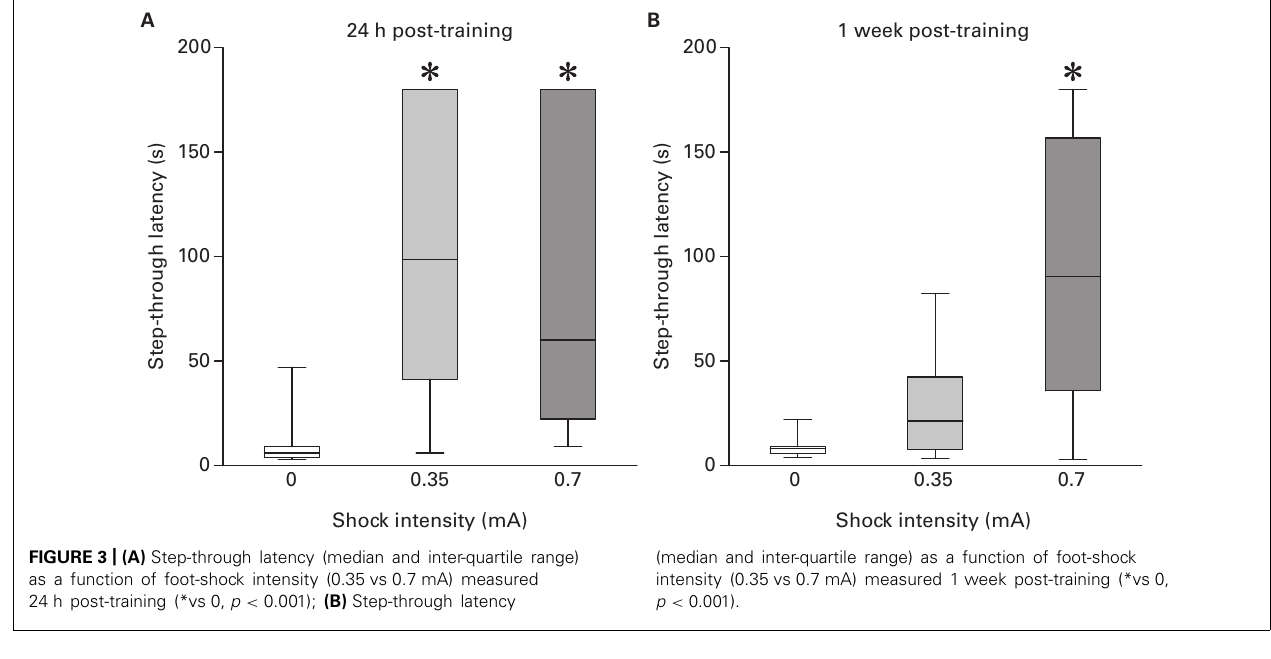
(median and inter-quartile range) as a function of foot-shock intensity (0.35 vs 0.7 mA) measured 1 week post-training (*vs 0, p < 0.001